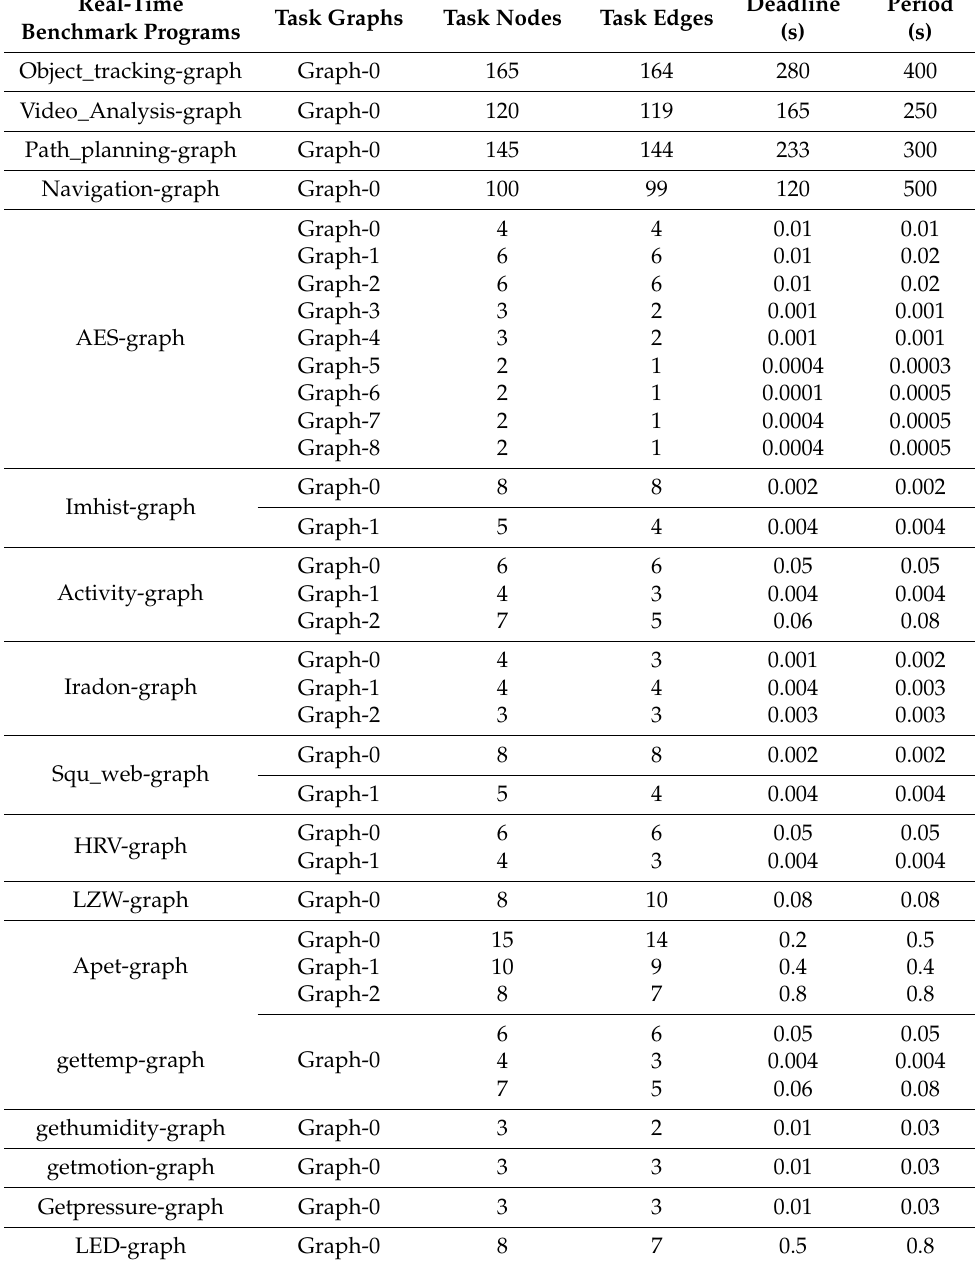
Table 6. Real-world Benchmark Task Graphs with